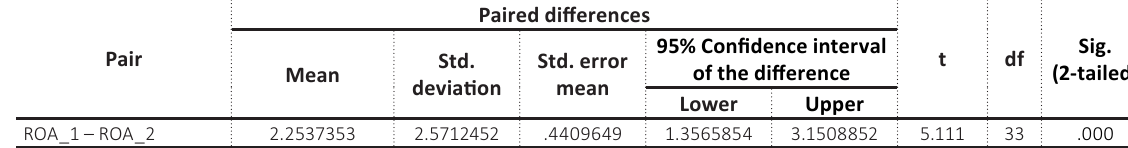
Table A8. Paired samples test (the result of H2b )